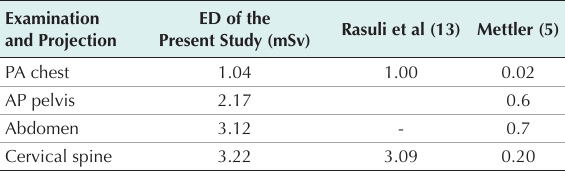
Table 3. Comparison Between the Present ED and That of Other Published